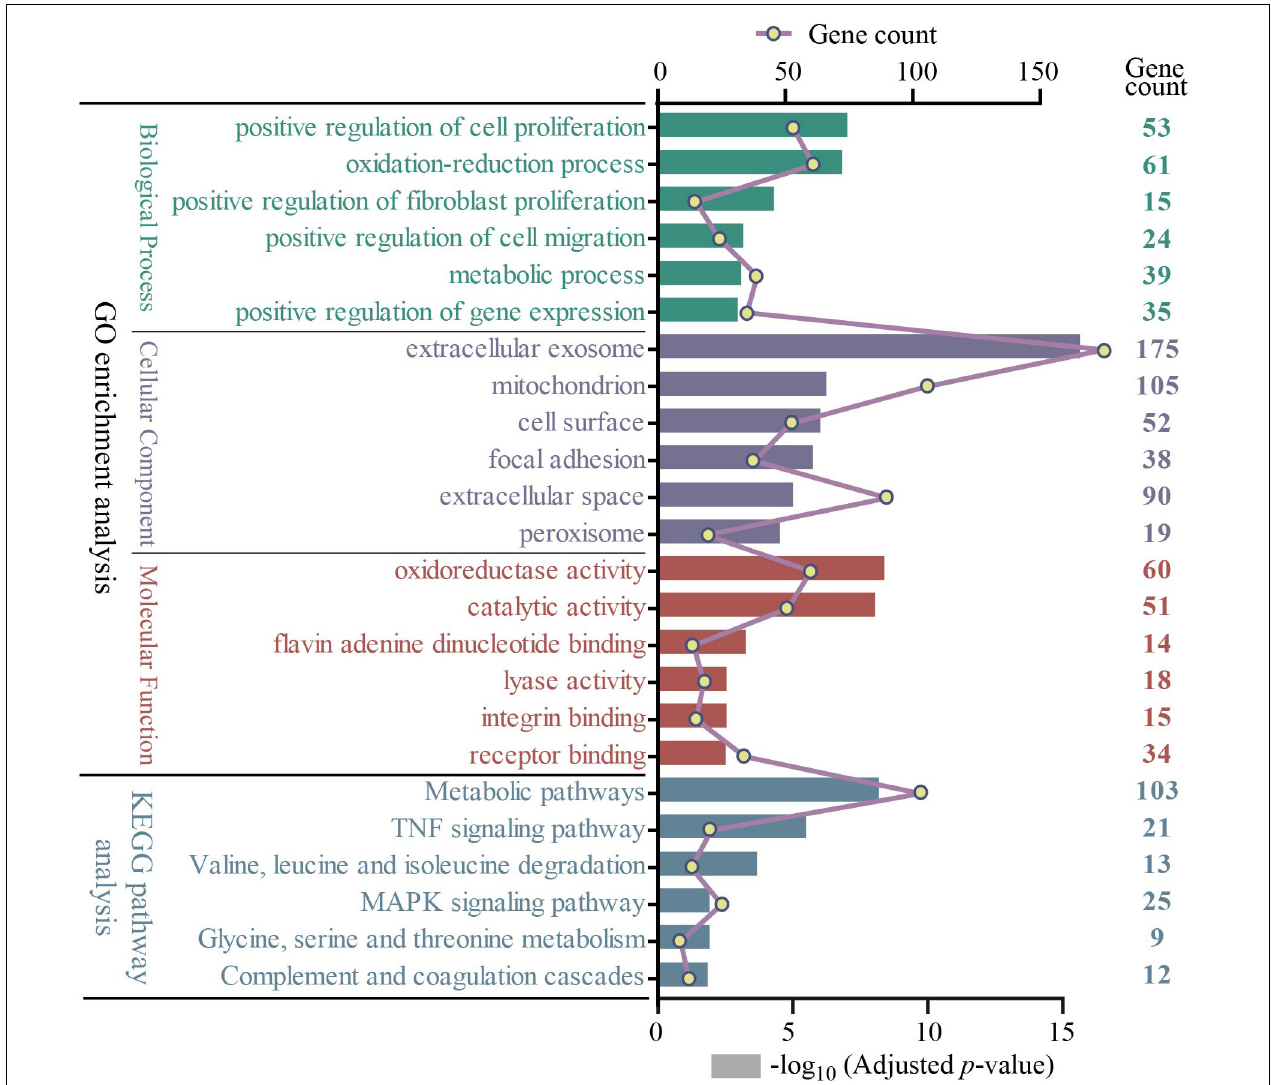
FIGURE 3 | The GO and KEGG pathway enrichment analysis of 722 overlapping DEGs (top 6 were listed). Four different colors separately represent four different categories: biological process, cellular component, molecular function, and KEGG pathway. The rectangle represents − log10 (adjusted p- value); the line and point represent gene count. GO, Gene Ontology; KEGG, Kyoto Encyclopedia of Genes and